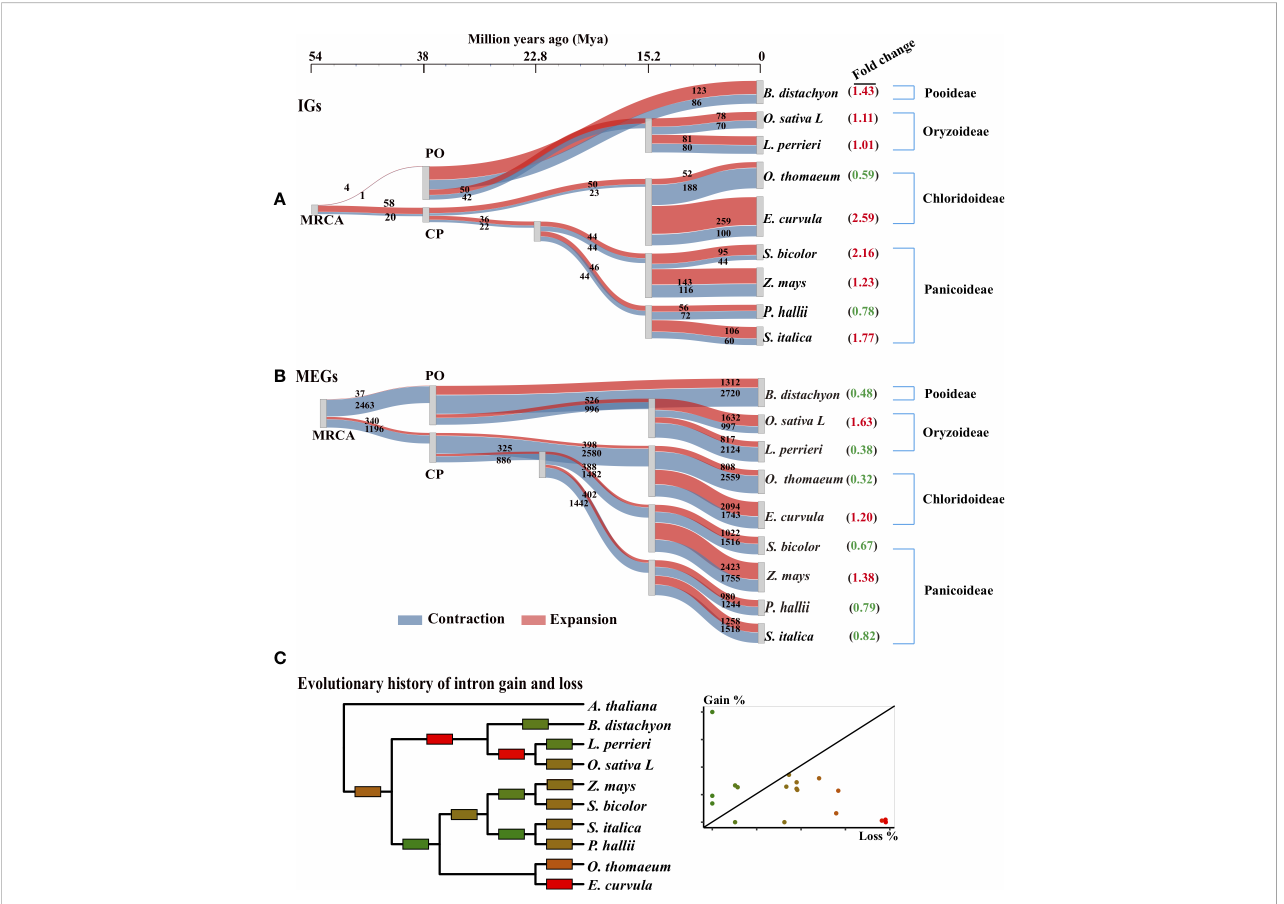
FIGURE 3 Evolutionary trajectory of IGs in Poaceae . (A, B) Gene family expansion and contraction along the phylogenetic tree for IG and MEG families. The 242 single-copy orthologous gene groups of nine Poaceae species were used to reconstruct the phylogenetic tree with two outgroups ( Cinnamomum chinensis and Arabidopsis thaliana ; not shown). The most recent common ancestors (MRCAs) of Poaceae represent the tree root. Three species are from the Pooideae and Oryzoideae (PO) clade and six are from the Chloridoideae and Panicoideae (CP) clade. A Sankey diagram shows the fl ow rate of gene families along the tree, where the width of each element is proportional to the expansion (red) and contraction (blue) of the gene family. The number of genes in each family is displayed on the element. The fold change (expansion to contraction) in the number of genes in each family is shown in parentheses. (C) Evolutionary history of intron gain and loss was reconstructed according to the Markov method (Cs ű rös et al., 2011). Edges are colored according to the relative amount of intron gain and loss as indicated in the scatter plot in which each point corresponds to an edge in the tree. Gain% is the percentage of introns gained in the given lineage from the parent node. Loss% is the percentage of the parental introns that were lost within the same